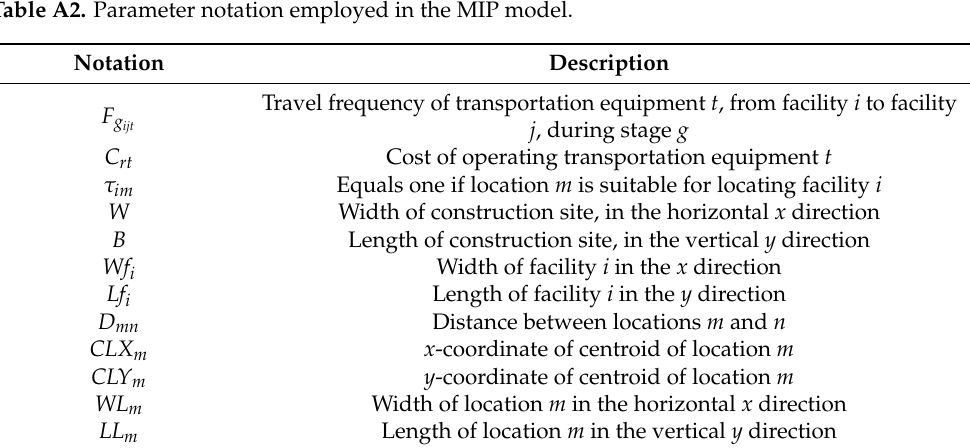
Table A2. Parameter notation employed in the MIP